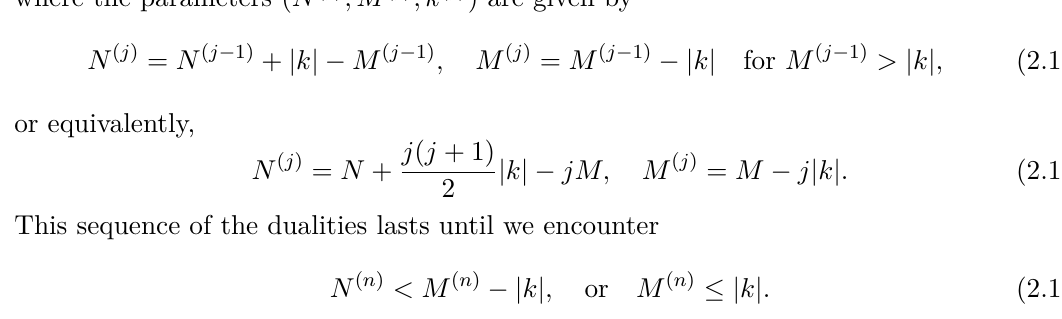
Figure 6 . Illustration of the sequence of the dualities among apparently different four theories. (1) The brane configuration corresponding to the N = 3 U( N ) 2 | k | < M ≤ 3 | k | ( N = 4 , M = 3 , k = 1 in this figure). (2) After the 1st Hanany-Witten move. (3) The same as the 2nd brane configuration since the both ends are identified. (4) After the 2nd Hanany-Witten move. (5) The same as the 4th brane configuration. (6) After the 3rd Hanany- Witten move. Applying the Hanany-Witten move once more gives the 4th brane